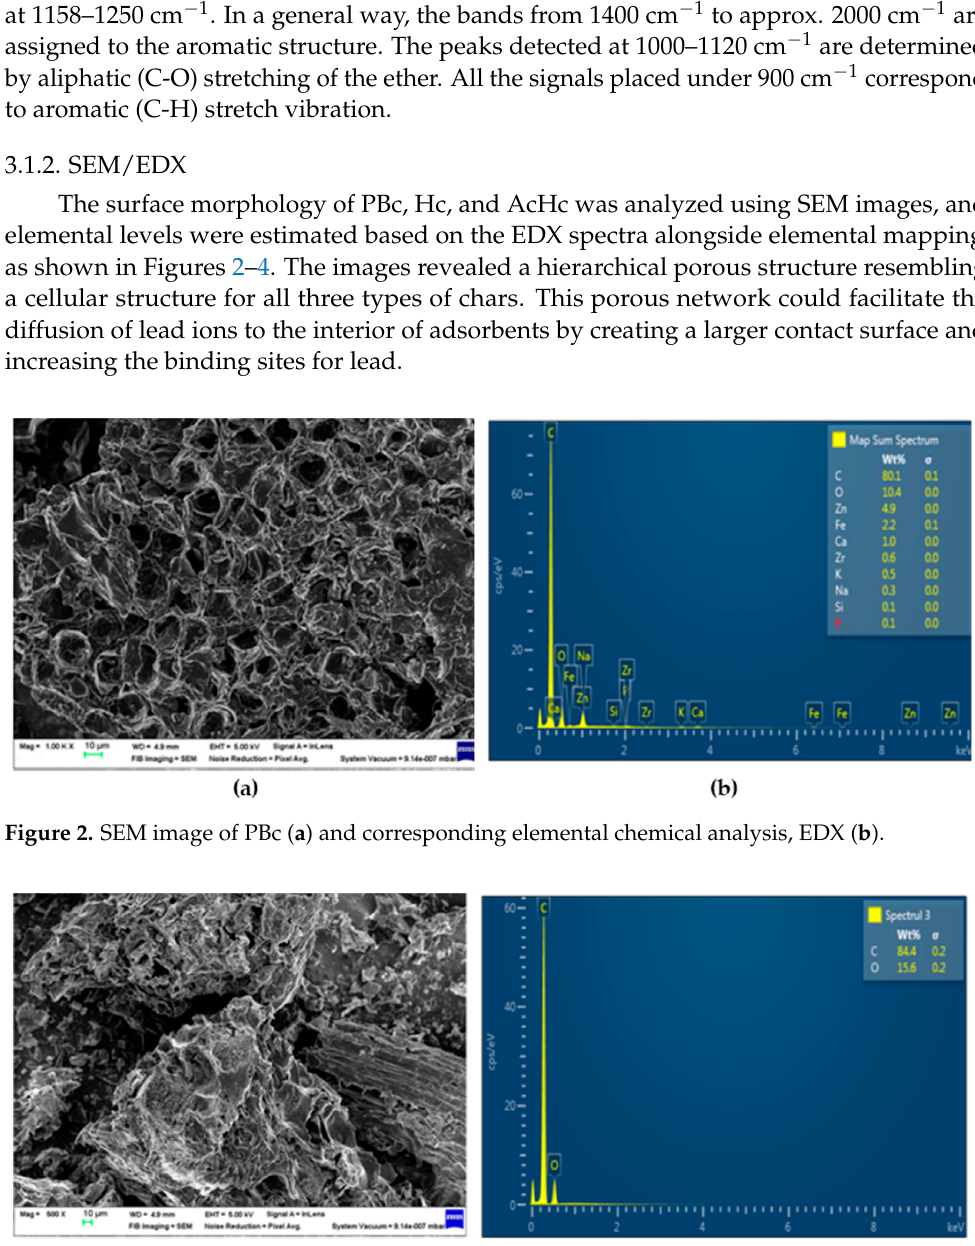
Figure 4. SEM image of AcHc ( a ) and corresponding elemental chemical analysis, EDX ( b ). The EDX analysis results reveal that carbon is the main component of bio-based sorbents, with a content ranging from 80 to 96%. Oxygen is also present in all examined structures, in the highest concentration in Hc. PBc and AcHc include a number of other chemical elements (Zn, Fe, Ca, Mn, Al, S) in low percentages. The elemental analysis data were obtained as an average of spectra of several surveyed areas of carbonaceous samples and are considered for comparative assessment.